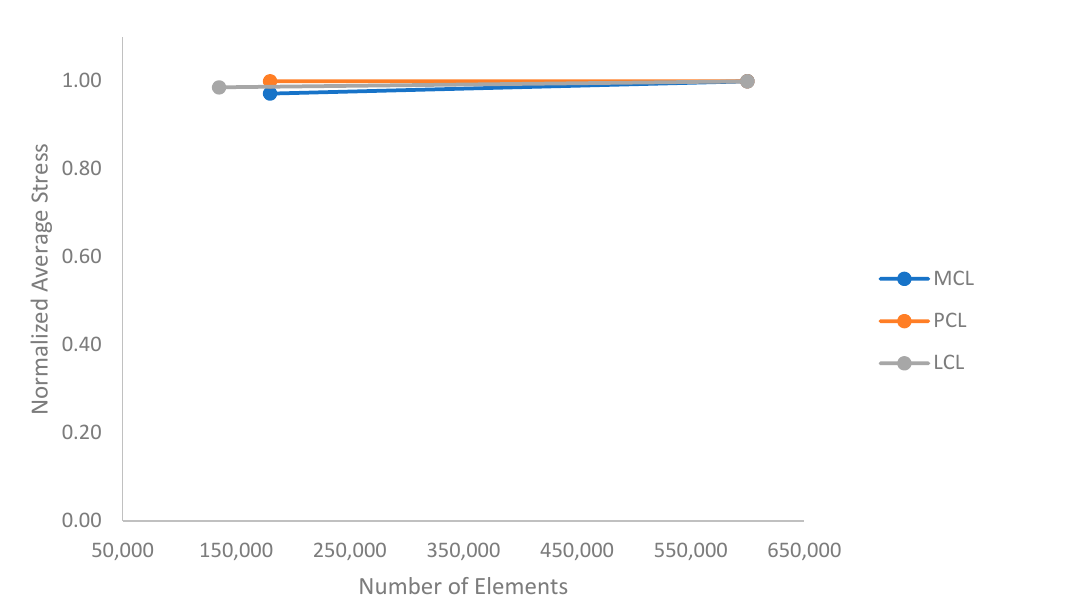
Figure 1. Illustration of loading and boundary conditions for damage initiation and subsequent examination. ( A ) To initiate damage, a quadriceps force loading of 2000 N was applied and removed. ( B ) Following damage initiation, an anterior shear force of up to 300 N was applied, or ( C ) a tibial torque up to 10 Nm was applied.